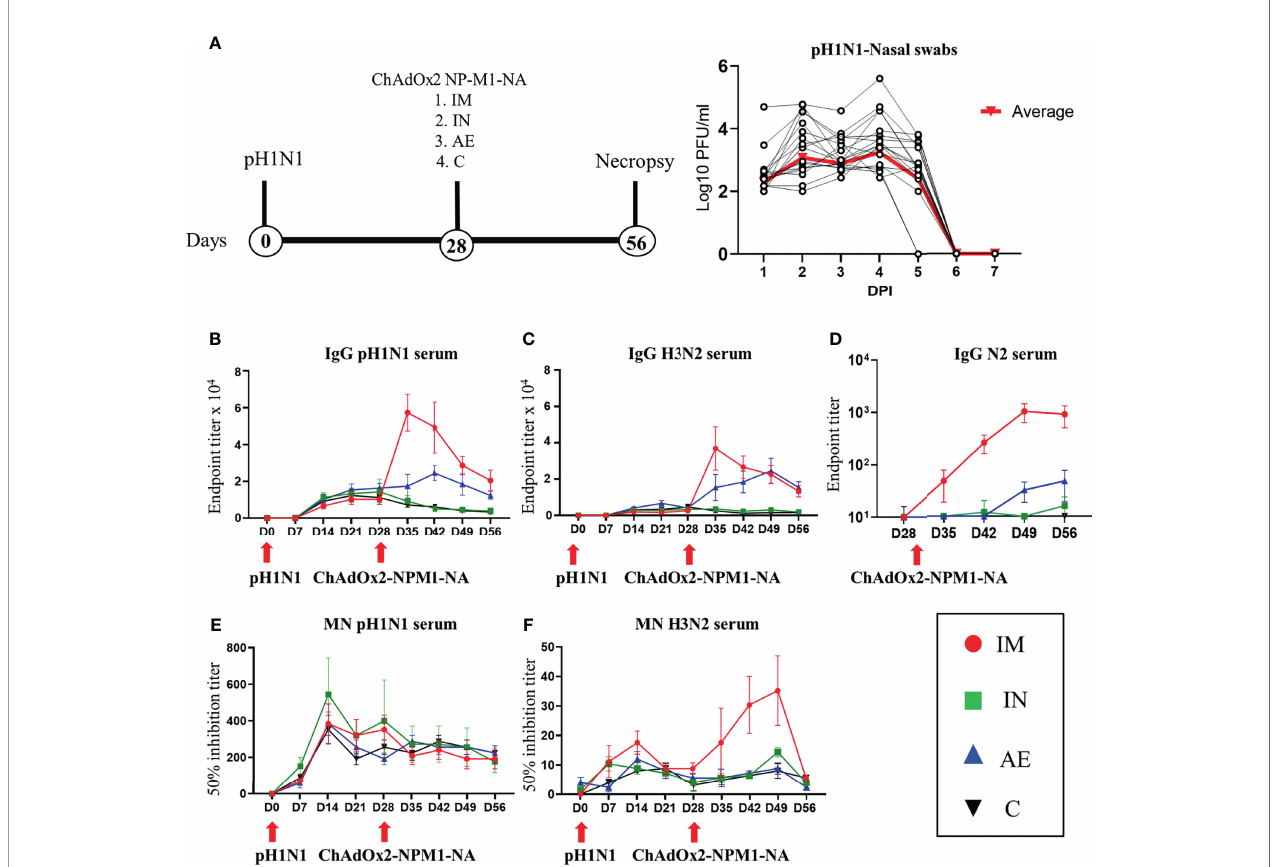
FIGURE 1 | Experimental design, viral load, and systemic antibody responses. (A) Twenty pigs were infected with pH1N1 in fl uenza A virus and, 4 weeks later, immunized with ChAdOx2-NPM1-NA intramuscularly (IM), intranasally (IN), or by aerosol (AE). Four weeks later, they were culled. Weekly blood samples were collected during the time course. Control (C) animals were infected but not immunized. Virus load was determined by plaque assay of daily nasal swabs (NS) obtained at the indicated days post-infection (DPI). Each black line represents one animal. The thick red line indicates the mean of 20 animals. (B) pH1N1-, (C) H3N2-, and (D) N2- speci fi c IgG responses in serum were determined by ELISA at the indicated time points. (E, F) Serum-neutralizing titers over time were determined by microneutralization (MN) of (E) pH1N1 and (F) H3N2 viruses. The mean and standard error (SEM) is presented in each time point. The arrows below D0 and D28 indicate challenge of the pigs with pH1N1 and immunization with ChAdOx2-NPM1-NA, respectively. Signi fi cant statistical differences are listed in Table 2